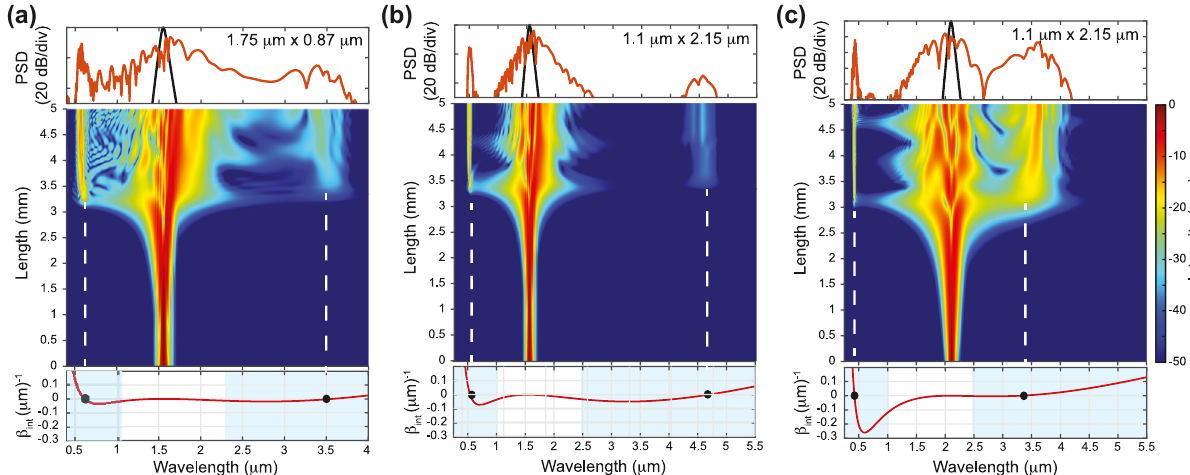
Figure 3: Illustration of dispersive wave engineering. Simulated spectrum on top (black – input, red – output), simulated spectral evolution along propagation in the middle and calculated integrated dispersion at the bottom for: (a) 1.75 μ m × 0.87 μ m waveguide pumped at 1550 nm in TE; (b) 1.1 μ m × 2.15 μ m waveguide pumped at 1550 nm in TM; (c) 1.1 μ m × 2.15 μ m waveguide pumped at 2100 nm in TM. The positions of the expected DWs = 0) and align well with the spectrum simulation highlighted by the white dashed lines. are indicated by black dots in the integrated dispersion ( 𝛽 int The regions of normal dispersion are identified in light blue in the bottom graphs. Numerical simulations are performed by solving the GNLSE for the same peak pump power of 5